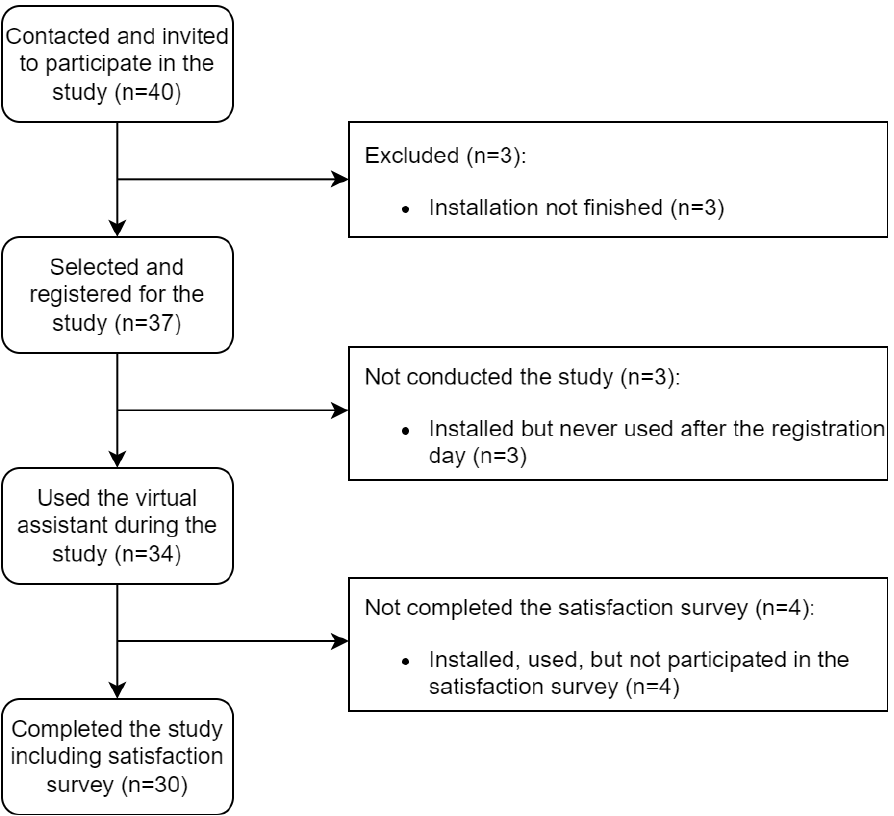
Figure 3. Patient selection, exclusion, and completion of the